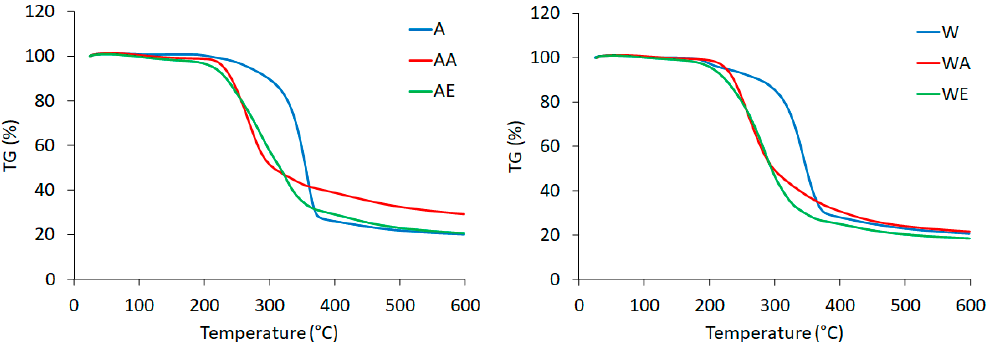
Figure 6. TG curves of (A) enzyme-pretreated Avicel cellulose, (AA) enzyme-pretreated Avicel cellulose treated with AmimCl, (AE) enzyme-pretreated Avicel cellulose treated with EmimOAc, (W) enzyme-pretreated Whatman cellulose, (WA) enzyme-pretreated Whatman cellulose treated with AmimCl, and (WE) enzyme-pretreated Whatman cellulose treated with EmimOAc.